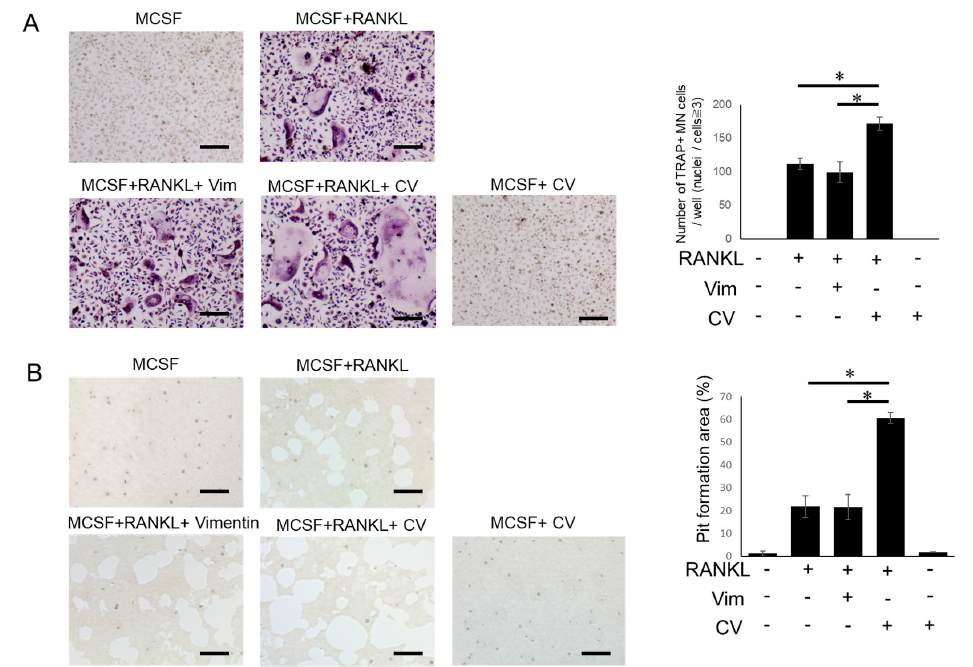
Figure 1. CV promotes RANKL-mediated OC-genesis. M-CSF (20 ng/mL)-primed OC precursors derived from mouse bone marrow were stimulated with RANKL (50 ng/mL) in the presence or absence of vimentin (Vim) or CV for 7 days by exchanging 50% of culture medium with fresh medium every 3 days. ( A ) TRAP staining and ( B ) pit formation assay were performed. The number of TRAP-positive cells with more than 3 nuclei were counted. The resorption pit area was measured using ImageJ. All in vitro assays were performed in triplicate and the results were expressed by the mean ± SD. All experiments were independently performed three times. * p < 0.01. Scale bar: 100 µm.